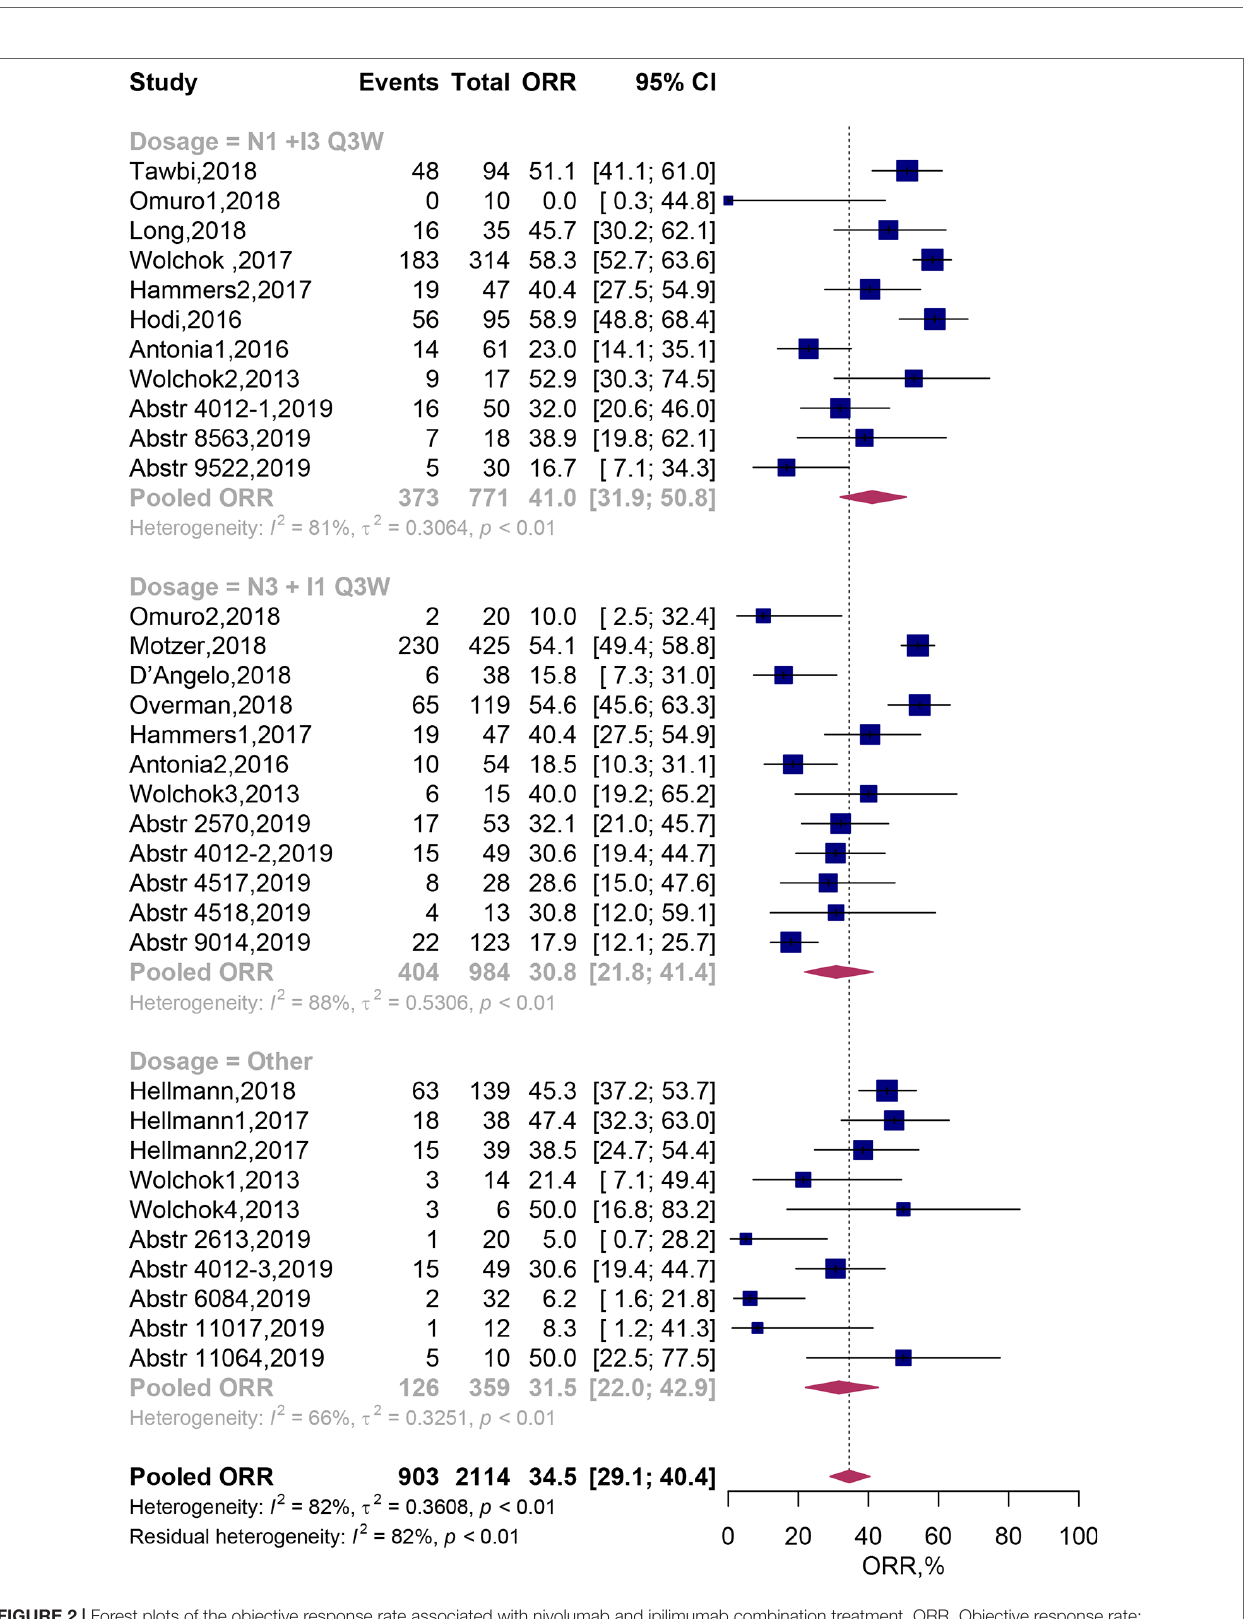
Frontiers in Pharmacology |